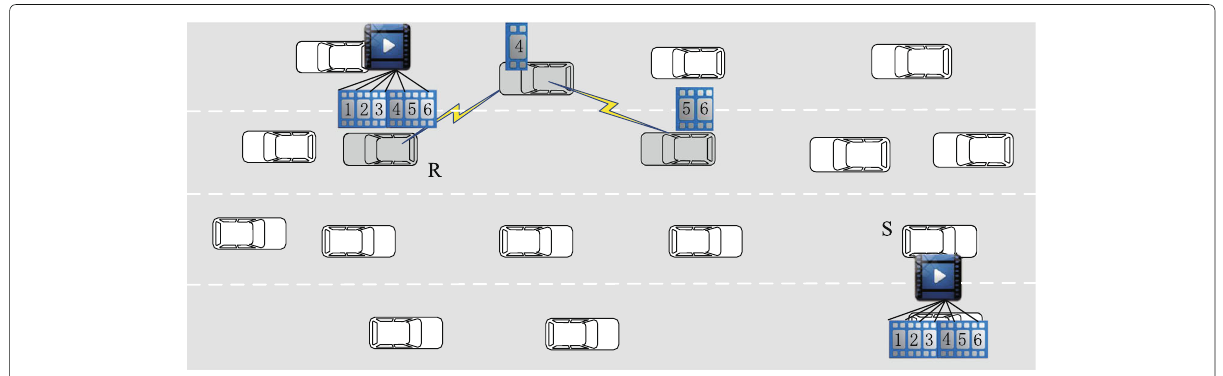
Fig. 4 Cluster members forward file pieces to request